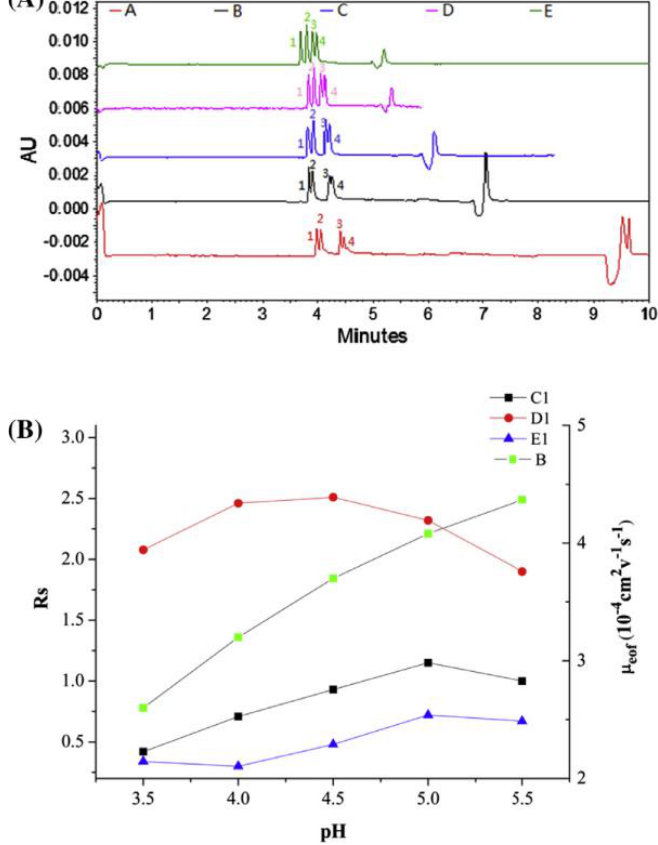
Figure 3. Effect of pH on ( A ), the separation phenomenon, and ( B ) resolution factors of the stereoisomers: cinchonidine (1), quinine (2); cinchonine (3); quinidine (4). (A) pH 3.5, (B) pH 4.0, (C) pH 4.5, (D) pH 5.0, (E) pH 5.5. (C1)—cinchonidine/quinine, (D1)–quinine/cinchonine, (E1)–cinchonine/quinidine), and (B)— µ eof of the diastereomers Reprinted with permission from Ref. [38].